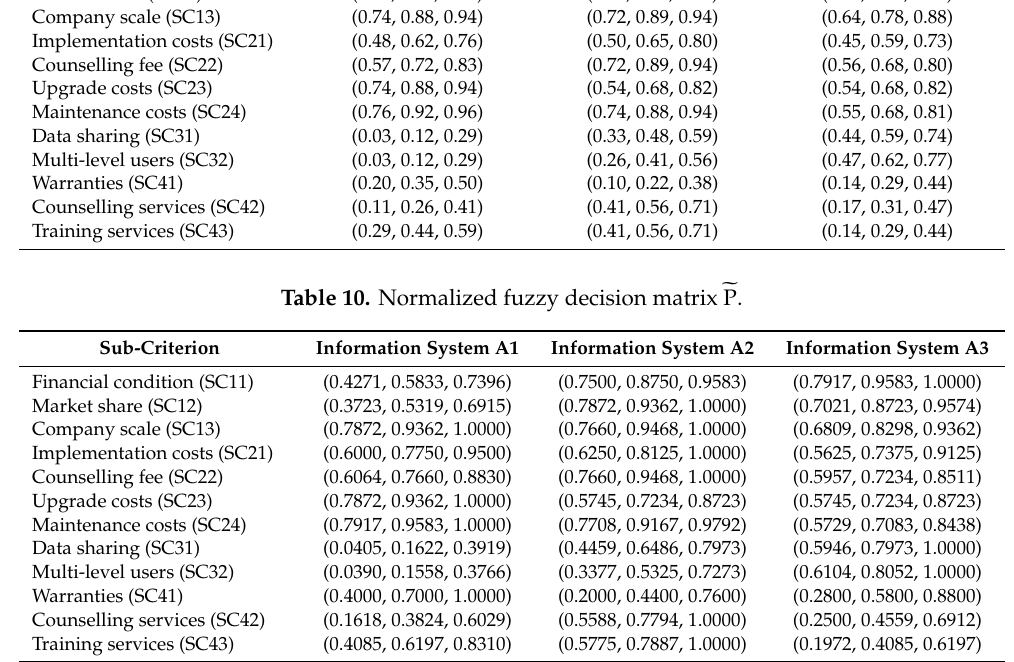
Table 9. Fuzzy decision matrix (cid:101) P